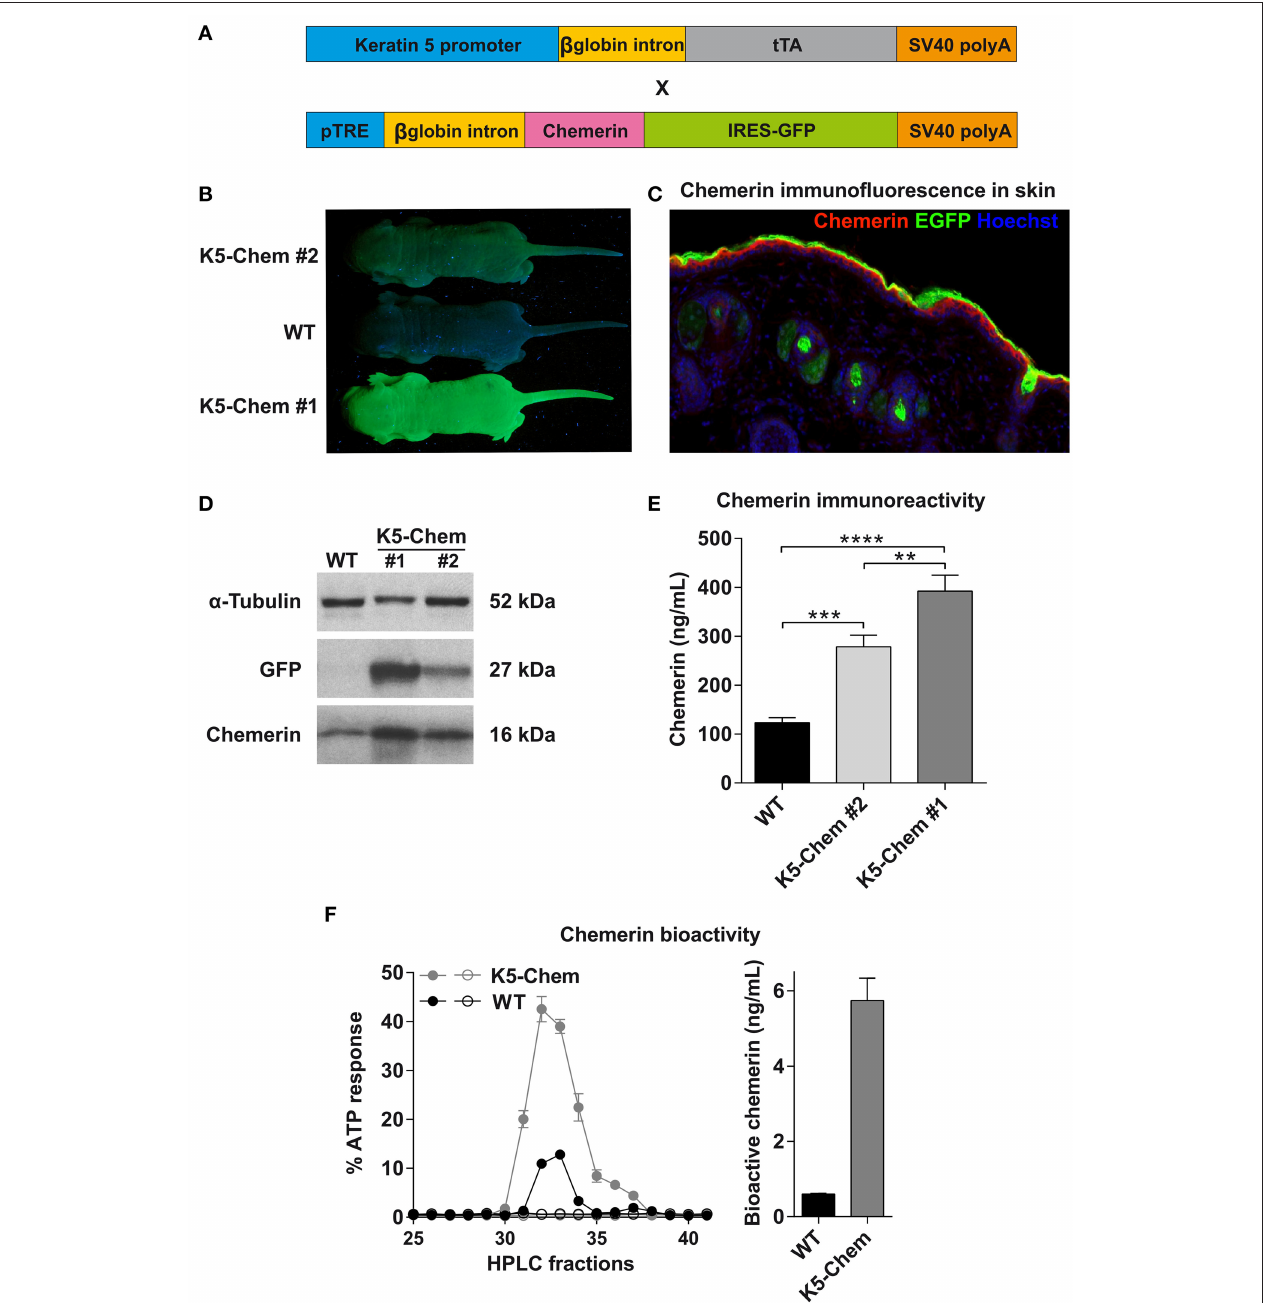
FIGURE 2 | Development of a mouse line expressing bioactive chemerin in keratinocytes. (A) Schematic representation of the constructs used to generate the K5-chemerin transgenic mice overexpressing bioactive chemerin and EGFP in keratinocytes. (B) Detection of EGFP fluorescence in the skin of newborn mice from two K5-chemerin lines and a control mouse (WT). (C) Detection by immunofluorescence of chemerin in a skin section of a K5-chemerin mouse (line # 1). (D) Detection by Western blotting of chemerin (16 kDa), EGFP (27 kDa) and α -tubulin (52 kDa, as control) in the skin from K5-chemerin (lines # 1 and # 2) and WT mice. Data are representative of four experiments. (E) Measurement by ELISA of chemerin immunoreactivity in plasma from control and K5-chemerin mice from two lines (mean ± SEM, n ≥ 5 mice per group). The data are representative of three experiments and analyzed by one-way ANOVA. ** P < 0.01; *** P < 0.001, and **** P < 0.0001. (F) Measurement of chemerin bioactivity in the plasma of control and K5-chemerin mice (line # 1). Pooled plasma was loaded on a heparin column and fractions tested in an aequorin-based intracellular Ca 2 + mobilization assay, using CHO-K1 cells expressing mouse ChemR23 (closed symbols) or not (open symbols). The activity is expressed as the percentage of the response obtained for 10 µ M ATP (left panel, representative experiment out of two). Bar graph representing the total bioactive chemerin level in plasma from control and K5-chemerin mice (right panel). For each condition, two pools of plasma were analyzed (mean ± SEM).